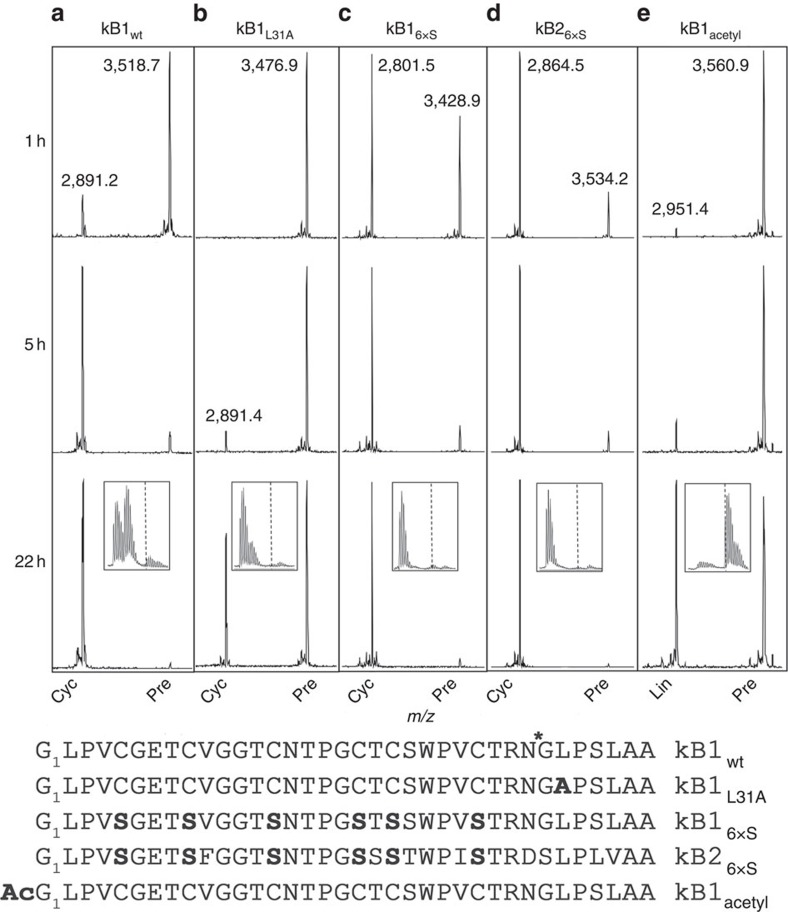
Modified linear kB1 and kB2 precursors are cyclized at different rates.MALDI MS spectra of (a) kB1wt, (b) kB1L31A, (c) kB16xS, (d) kB26xS and (e) kB1acetyl cyclotide precursors at 1, 5 and 22 h post-enzyme addition. Data are representative of three technical replicates. * denotes rOaAEP1b cleavage site. Observed monoisotopic masses (Da; [M+H]+) for dominant peaks are listed. Boxed inset at the 22 h time point zooms in on the region containing the processing product. Approximate positions of the monoisotopic mass of processed products is indicated by . Cyc, cyclic product; Lin, linear product; Pre, linear precursor.